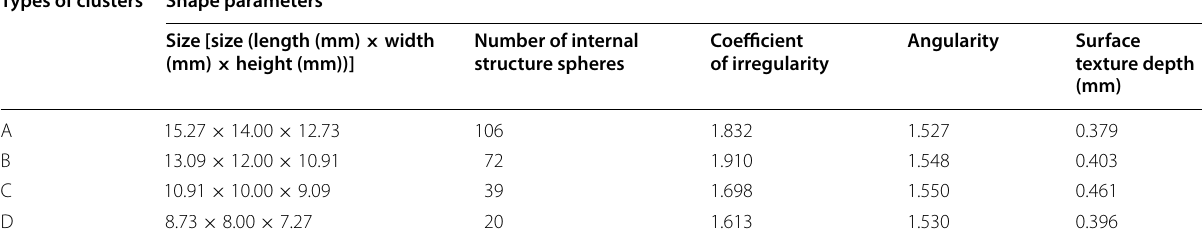
Table 1 Shape parameters of typical clusters before scaling. Types of clusters Shape parameters